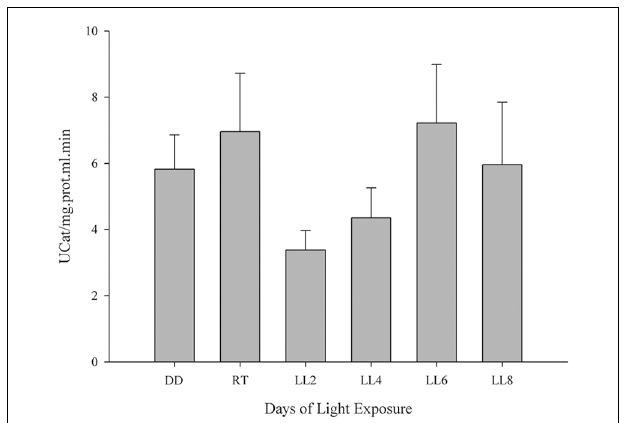
FIGURE 3 | Catalase activity study in retinal light damage. CAT activity expressed as U/mg prot.ml.min in controls (DD and RT) and rats exposed at different days of LL. Data are mean ± SE, n = 1 animal/group from three independent experiments, p = 0.216 by one-way ANOVA and Duncan’s post hoc